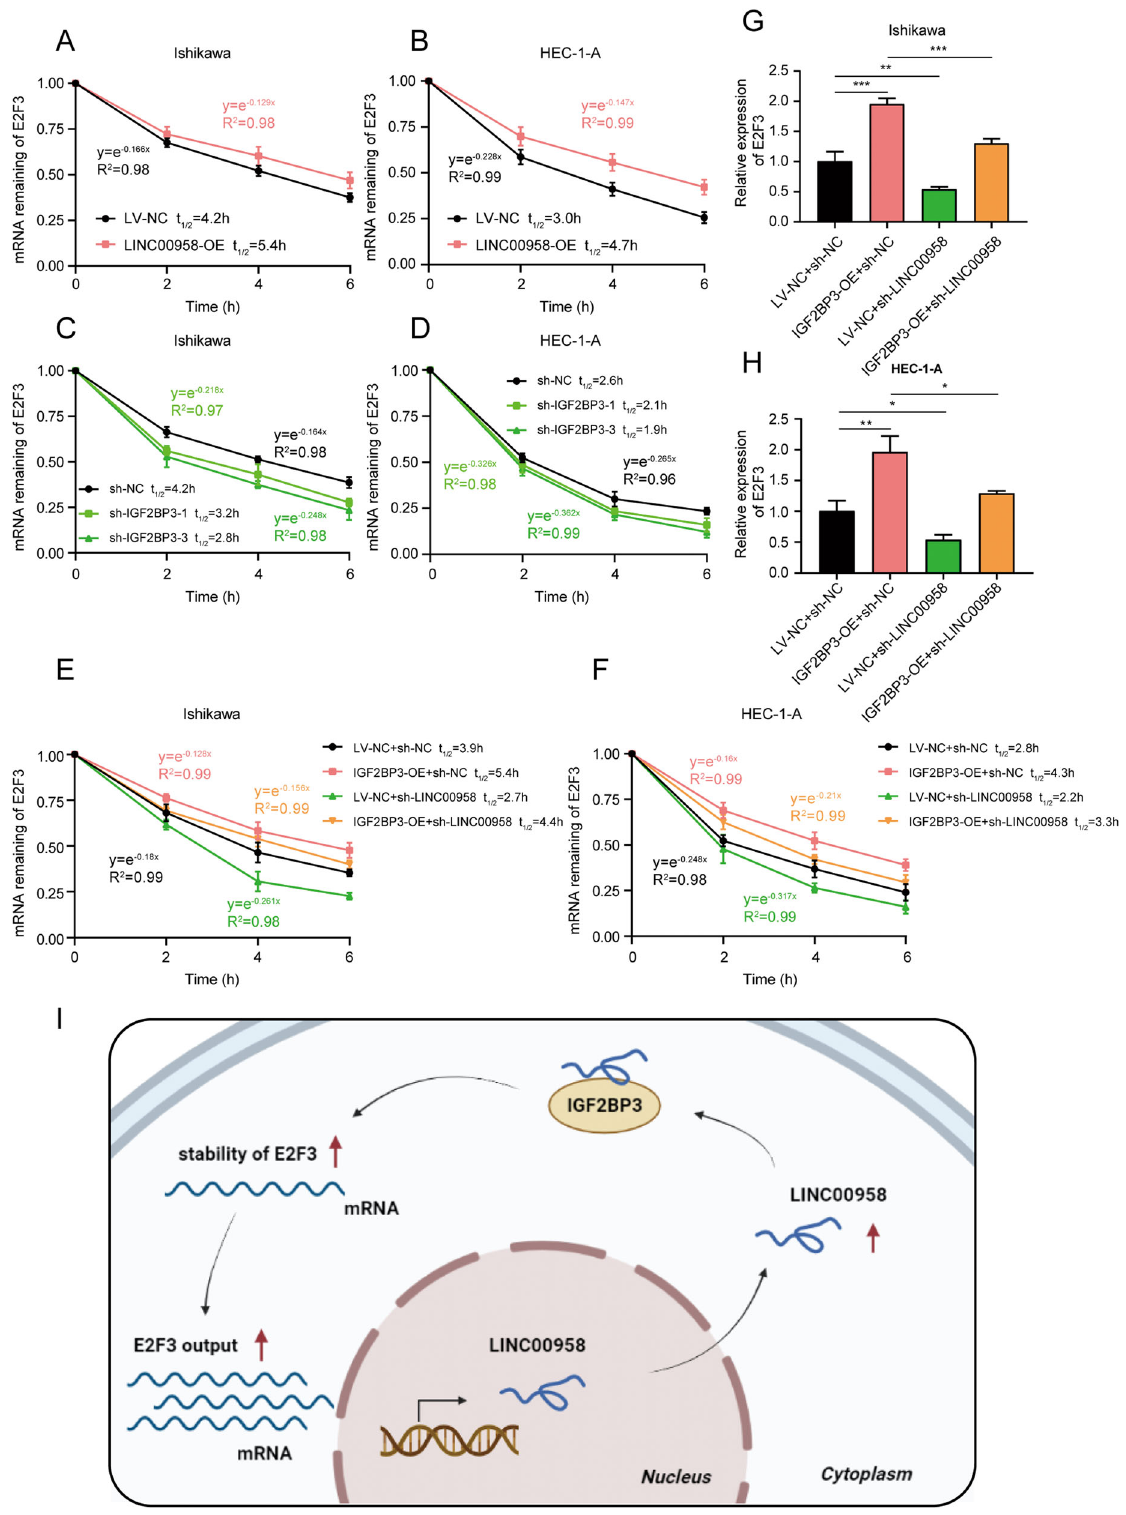
Fig. 8 IGF2BP3 promote E2F3 mRNA stability via LINC00958. A , B Prolonged E2F3 mRNA half-life by overexpressing LINC00958 in EC cells. C , D Shortened E2F3 mRNA half-life by knocking down IGF2BP3 in EC cells. E , F Silencing LINC00958 partially counteracted the improved mRNA stability of E2F3 caused by overexpression of IGF2BP3 in EC cells. G , H RT – qPCR assays showed E2F3 expression levels in IGF2BP3 – overexpressing EC cells combined with E2F3-silenced expression. I Schematic diagram created with BioRender.com illustrating the role of LINC00958 and IGF2BP3 in EC cells. * P < 0.05, ** P < 0.01, *** P < 0.001. Data, mean ± S.D. All experiments were independently repeated with at least three replicates.